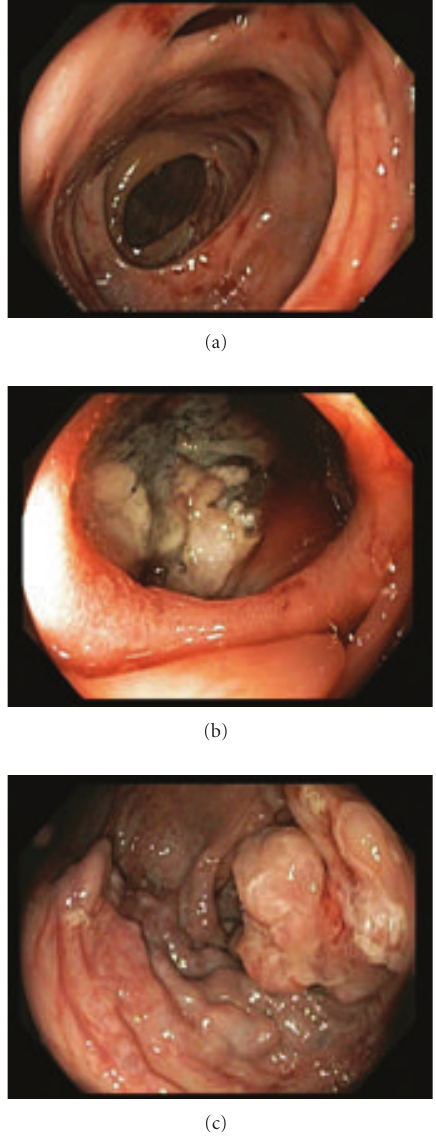
Figure 1: (a) Ascending colon with ileocecal valve in the distance and cavity at the 12 o’clock position. (b) View into cavity. (c) Mass and varices seen distal to the cavity.